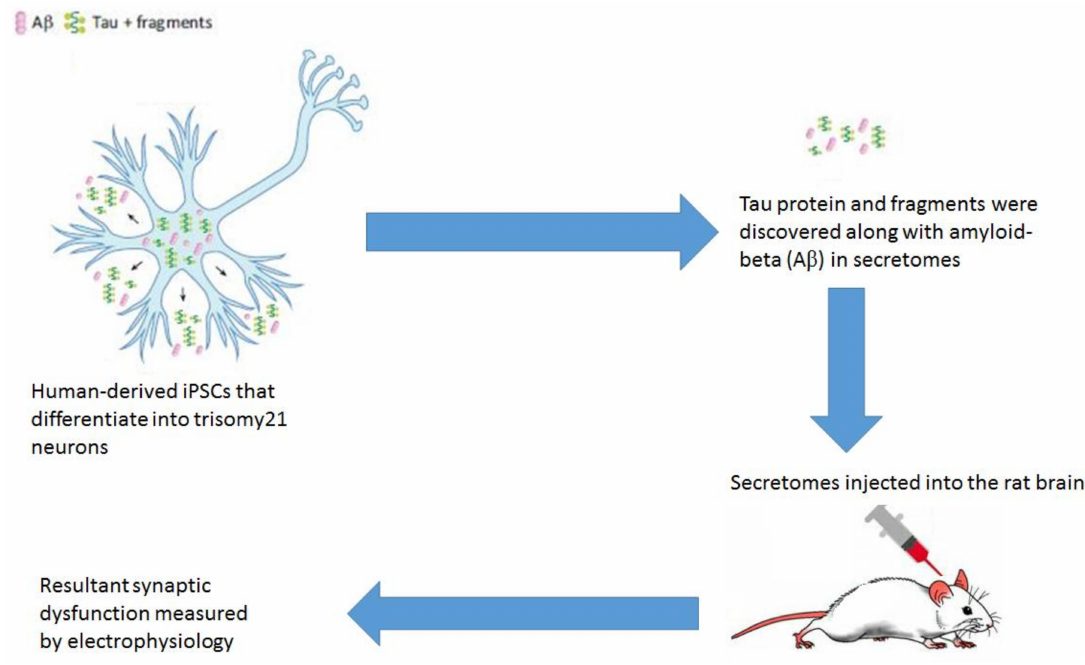
Figure 2. Synaptic dysfunction in rat model caused by secretomes from human derived iPSCs (Adapted from